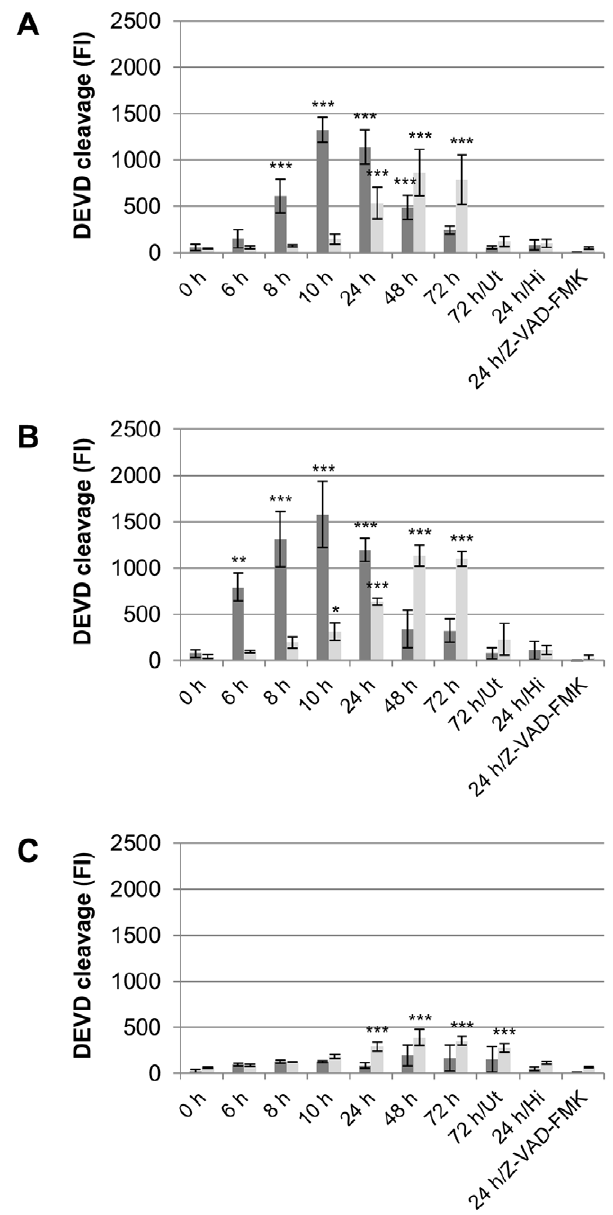
Figure 4. Time course of Parachlamydiaceae -induced effector caspase activity in S2 cells. S2 cells were infected with Pa. acanthamoebae (A), P. amoebophila (B), or S. negevensis (C) at a MOI of 5. Untreated cells (Ut) and cells treated with heat-inactivated bacteria (Hi) or with infectious bacteria in the presence of the pan caspase inhibitor Z-VAD-FMK (10 m M) served as controls. Activity of effector caspases in cell lysates (dark gray) and culture supernatants (light gray) was measured at indicated time points by application of an in vitro DEVD cleavage assay, in which substrate cleavage results in an increase in fluorescence intensity (FI). Mean values and standard deviations of four replicates are shown. Statistical significant differences compared to 0 h p.i. are indicated (ANOVA & Scheffe´ ; ***, p # 0.001; **, p # 0.01; *, p # 0.05). ActD-treated cells (14 h) were used as additional positive control for the assay and resulted in mean fluorescence intensities of 3261 and 658 (standard deviation 1010 and 473) in cell lysates and supernatants,